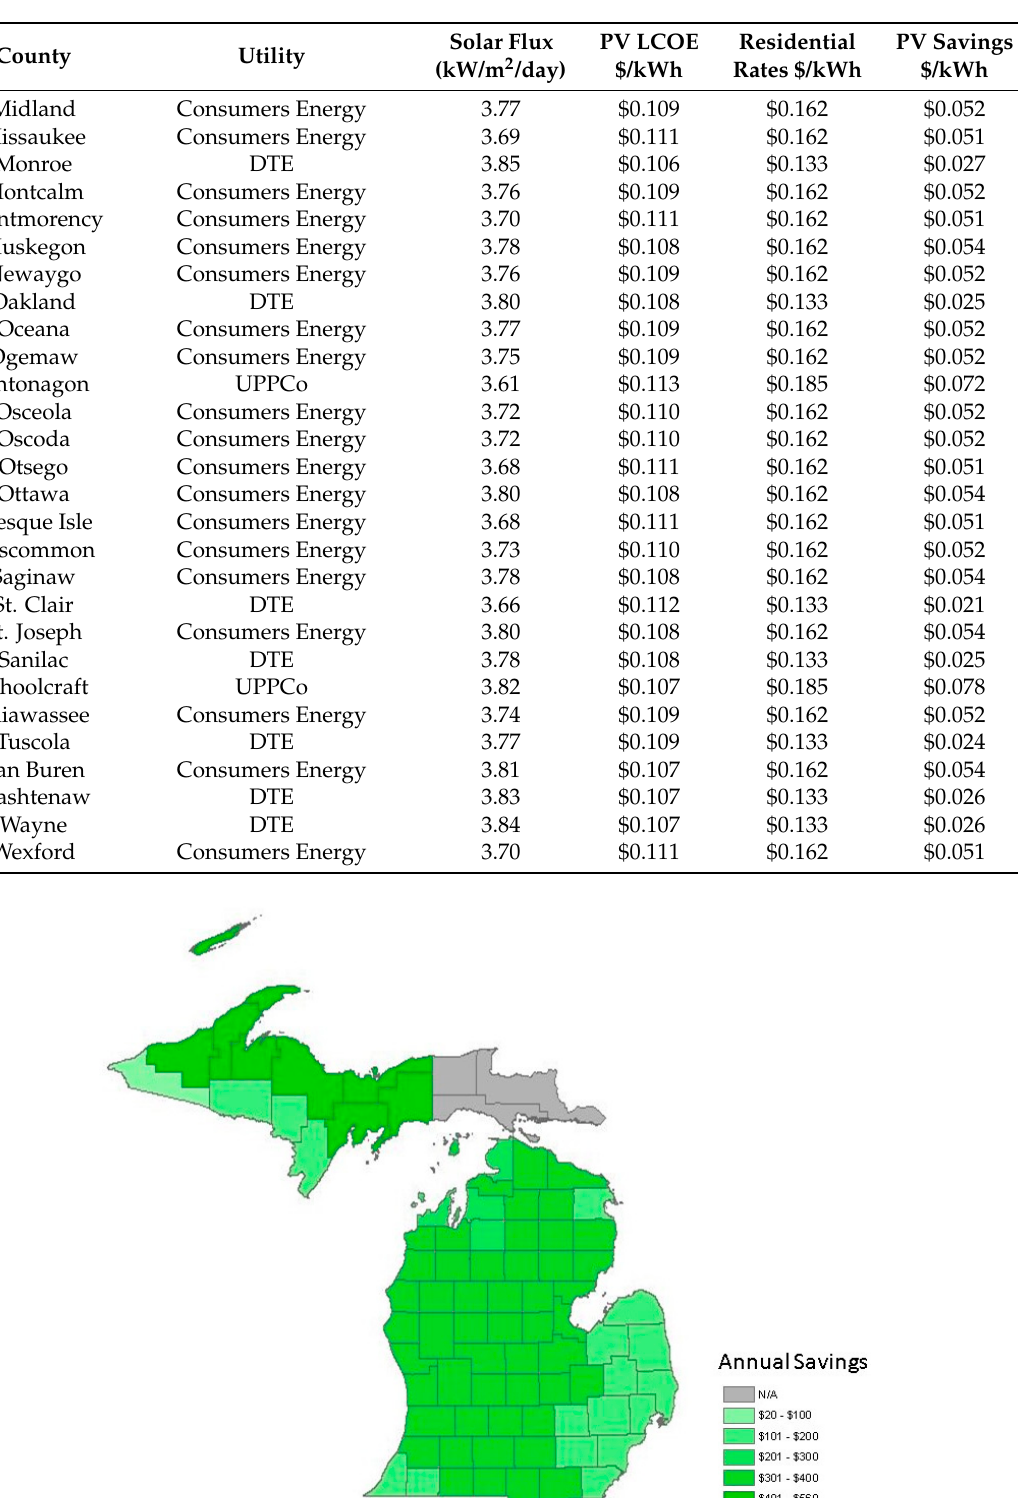
Figure 1. Savings ($/kWh) provided to each Michigan county from residential solar PV.